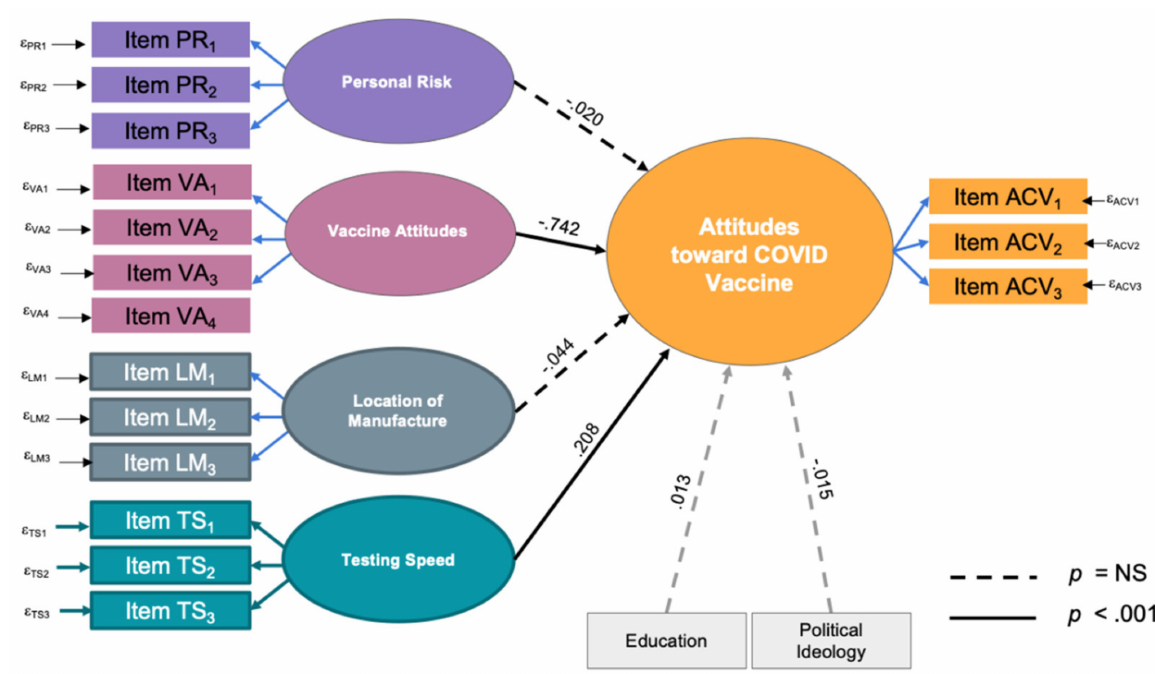
Figure 6. Structural equation model. Four variables, each represented by three survey items, were tested for model fit, and then analyzed for prediction of the output variable, attitudes toward COVID vaccination. Each rectangle represents a survey item as described in Table 2. Solid lines show statistically significant predictive ability while dashed lines show nonsignificant associations. Negative overall vaccine attitudes and a strong perception of too-rapid vaccine testing were predictive of worse attitudes towards receiving a COVID-19 vaccine. Education and political ideology were tested as covariates and did not show significant prediction of COVID-19 vaccine